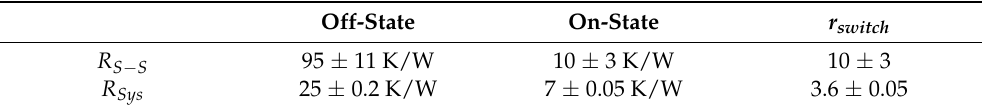
Table 2. Thermal resistances and switching ratios, r switch taken from Figure 5. For calculation, the average R S − S and R Sys from ramp-up and ramp-down phases were